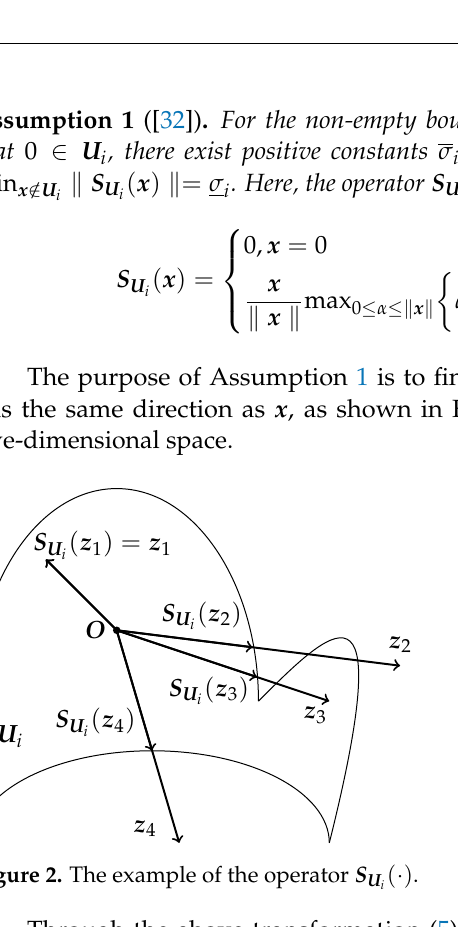
Figure 2. The example of the operator S U